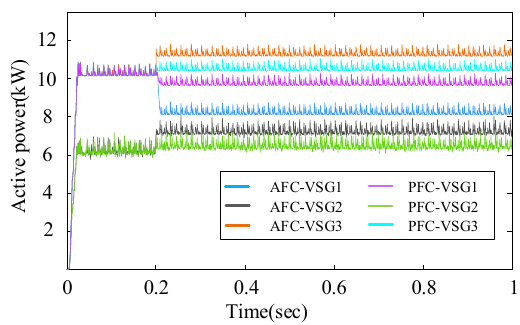
Figure 13. Active power regulation ability between the PFC-VSG and the AFC-VSG.